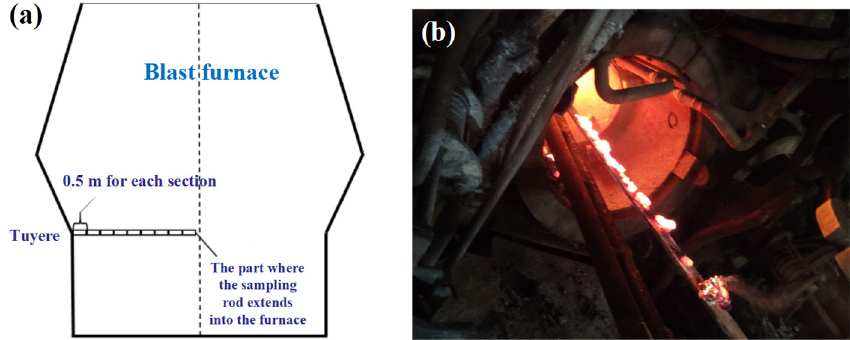
Figure 1. ( a ) Schematic diagram of sampling at blast furnace; ( b ) Live tuyere sampling on